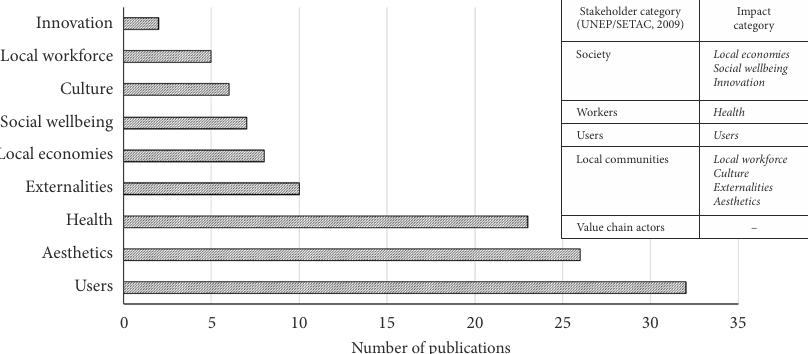
Figure 6. Social impact categories considered in the sustainability assessment of